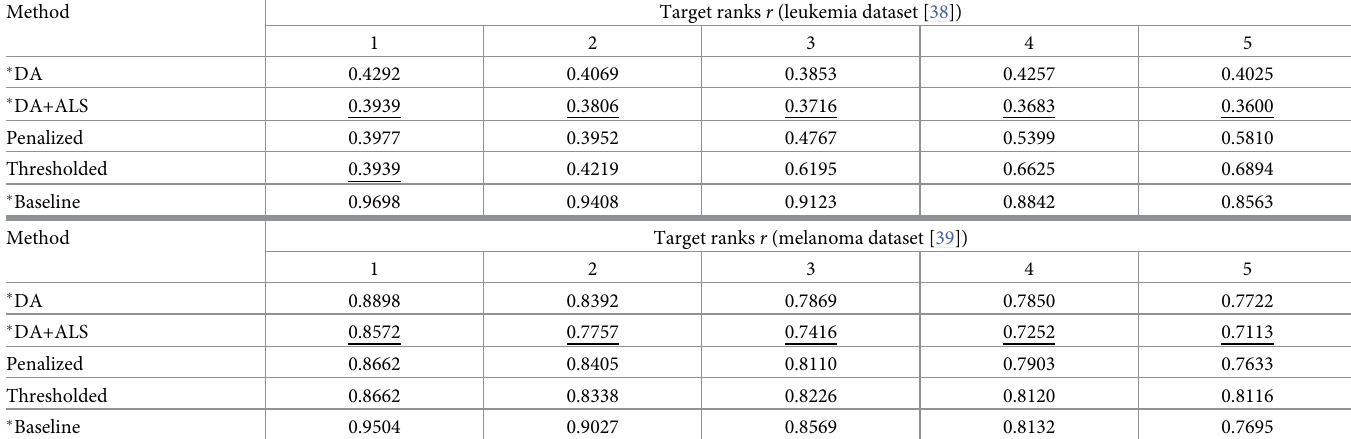
Table 6. Mean relative error for gene expression data. The � symbol indicates methods we propose. Best results are underlined.